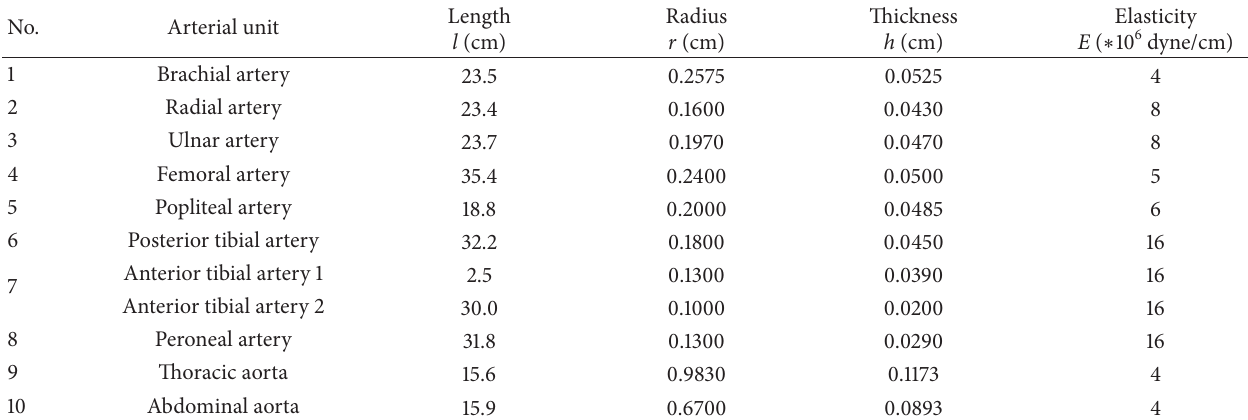
Table 1: Physiologic geometry data of main arteries in the model.